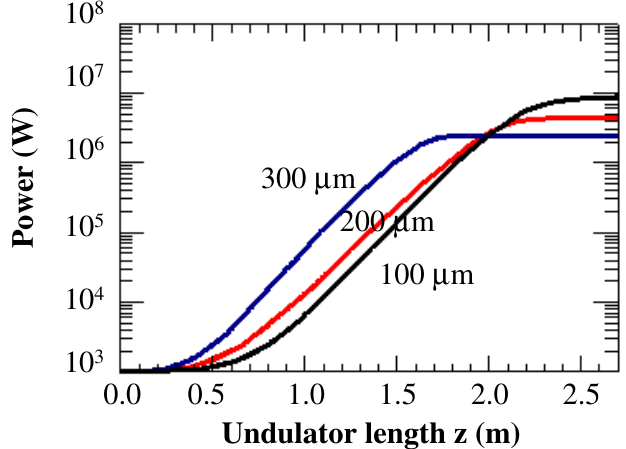
FIG. 2. (Color) Calculated THz power as a function of the undulator length z for a fixed peak current of 60 A and different wavelengths.